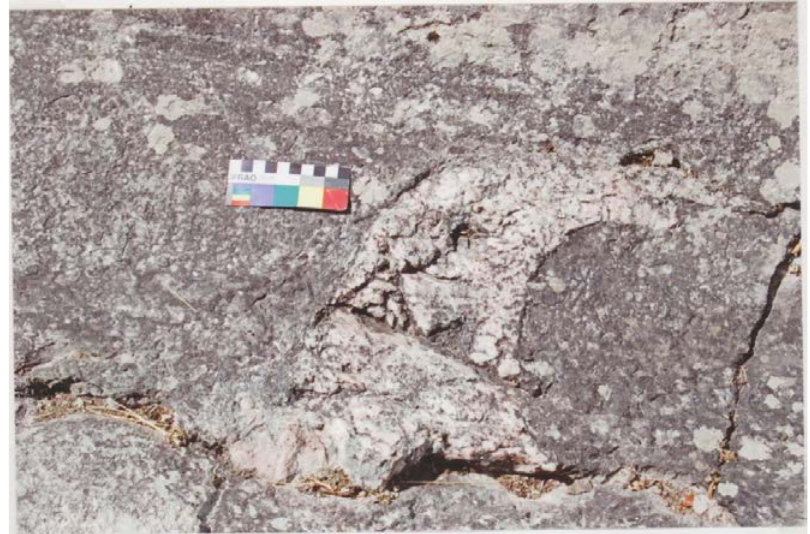
Figure 20. ( a ) View of main panel from the north. Like many other rock art